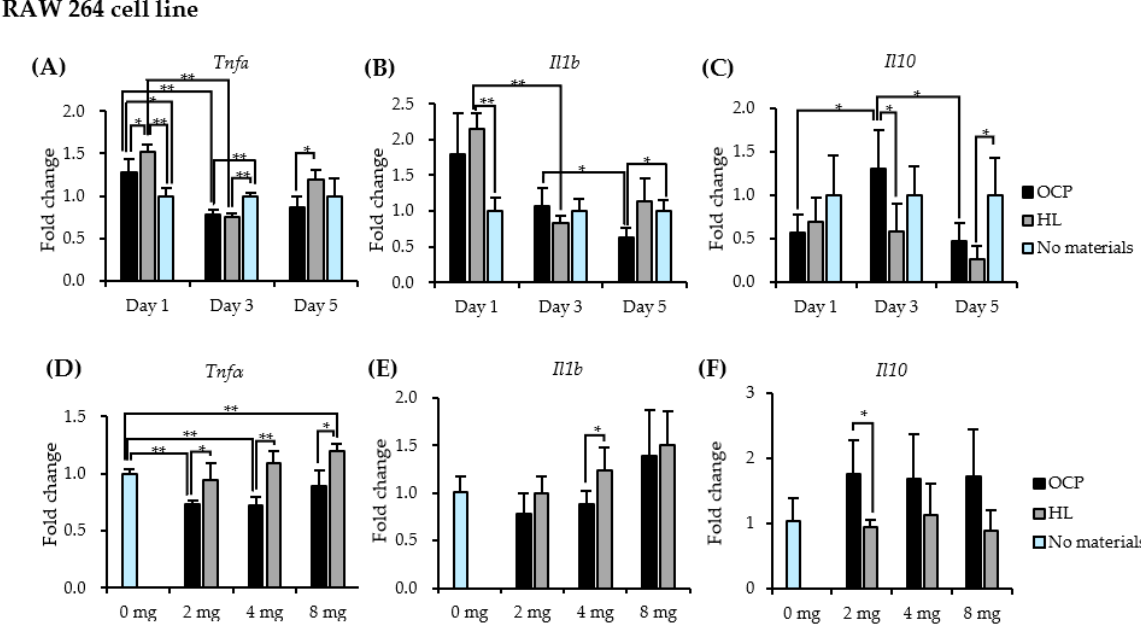
Figure 5. Responses of RAW cells to calcium phosphate granules. ( A – C ) The expression of Tnf α , Il1 β , and Il10 on RAW 264 macrophages with or without the treatment of 4.0 mg OCP or HL granules for 1, 3, and 5 days. ( n = 4) ( D – F ) The expression of Tnf α , Il1 β , and Il10 on RAW 264 macrophages with different doses of OCP or HL granules (2, 4, and 8 mg) for 3 days. ( n = 4) ** p < 0.01, * p < 0.05.